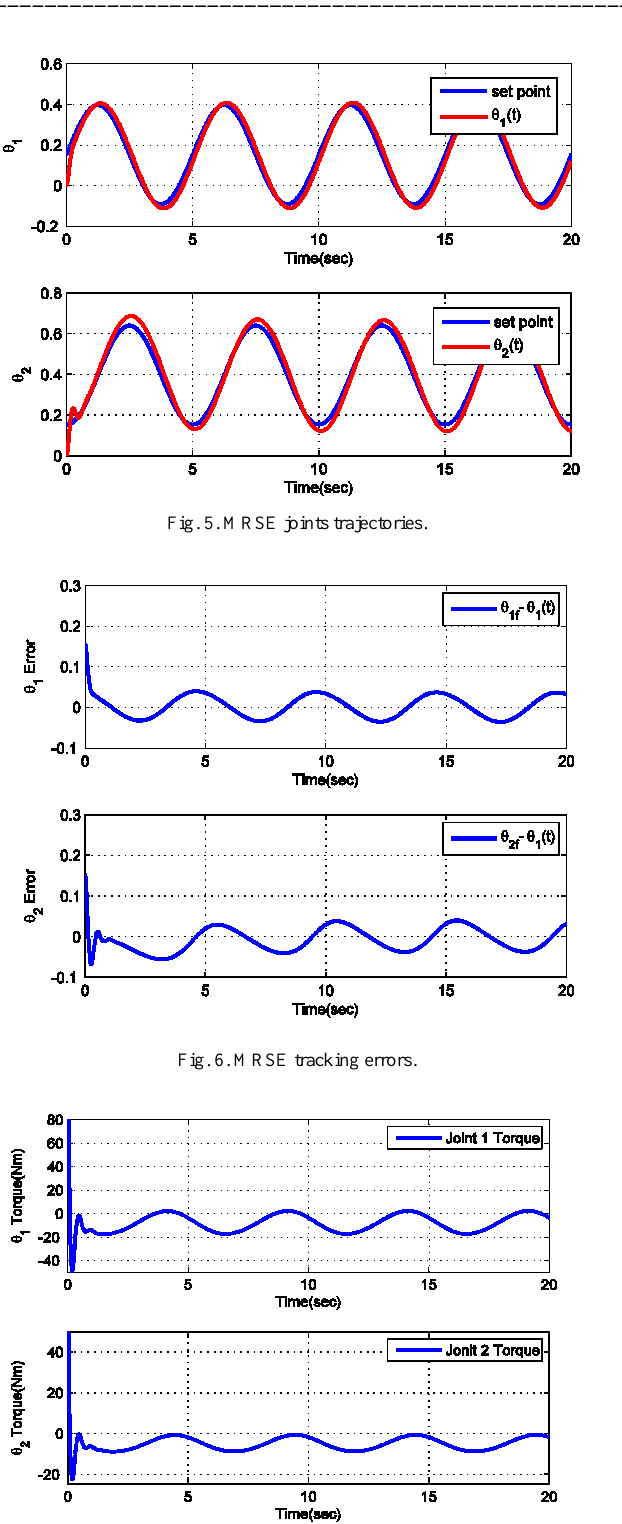
Fig. 7. MRSE optimal applied torque.